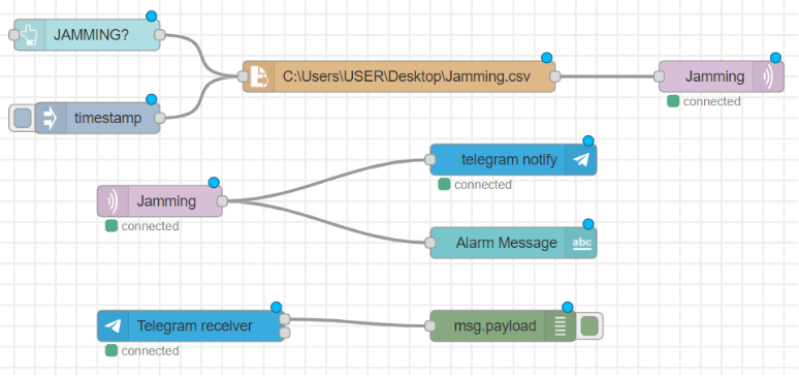
Figure 18. Node-red: Communication to Telegram Bot and Historic data through MQTT protocol. Two approaches taken to measure asset resilience without human intervention versus human advice are shown in the next subsection.